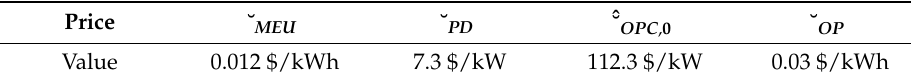
Table 1. Prices used for the simulation and field